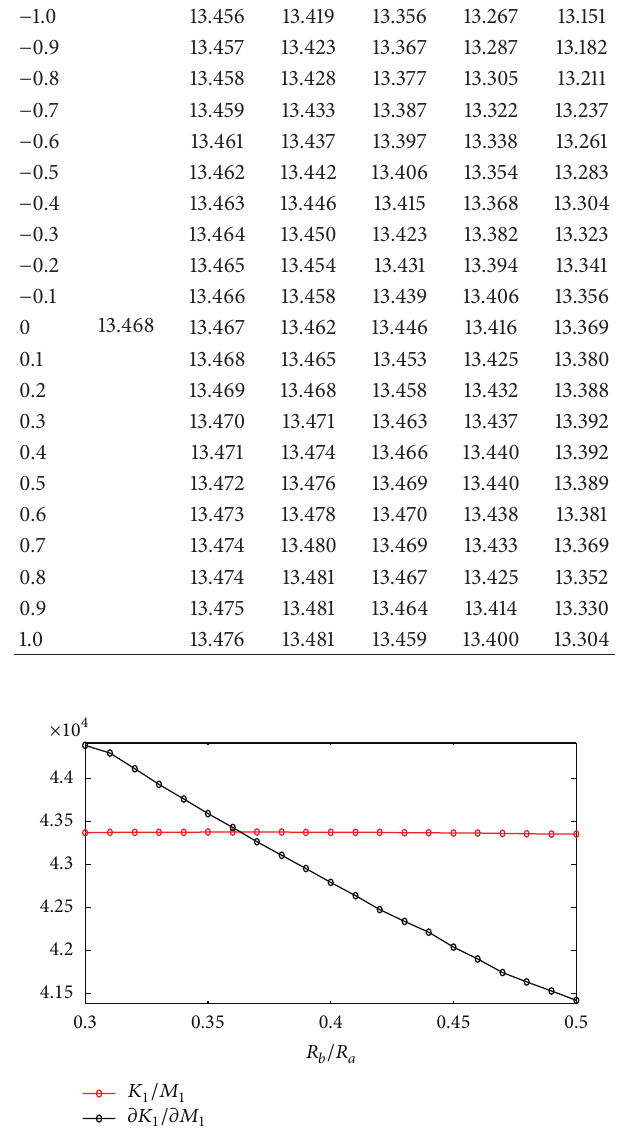
, K , K co , and K are stiffness matrix of the where K be in sp shell corresponding to the bending energy, the membrane energy, the coupling energy between out-of-plane and in- plane motions, and potential energy stored in the